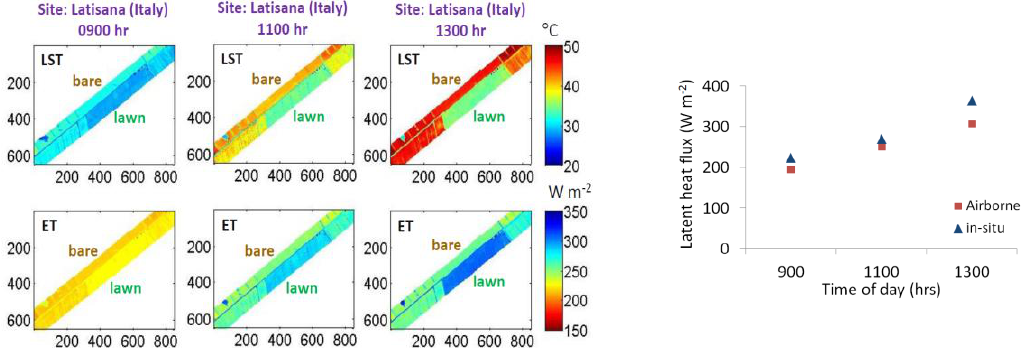
Figure 6. Retrieval of LST and ET from vegetated and non-vegetated areas in Latisana (left) and comparison of the airborne latent heat flux with in situ eddy covariance data. Axes depict pixel numbers (pixel size = 0.5 m) with the origin in the upper right image. The shown image strip is about 80 m wide and 600 m long.